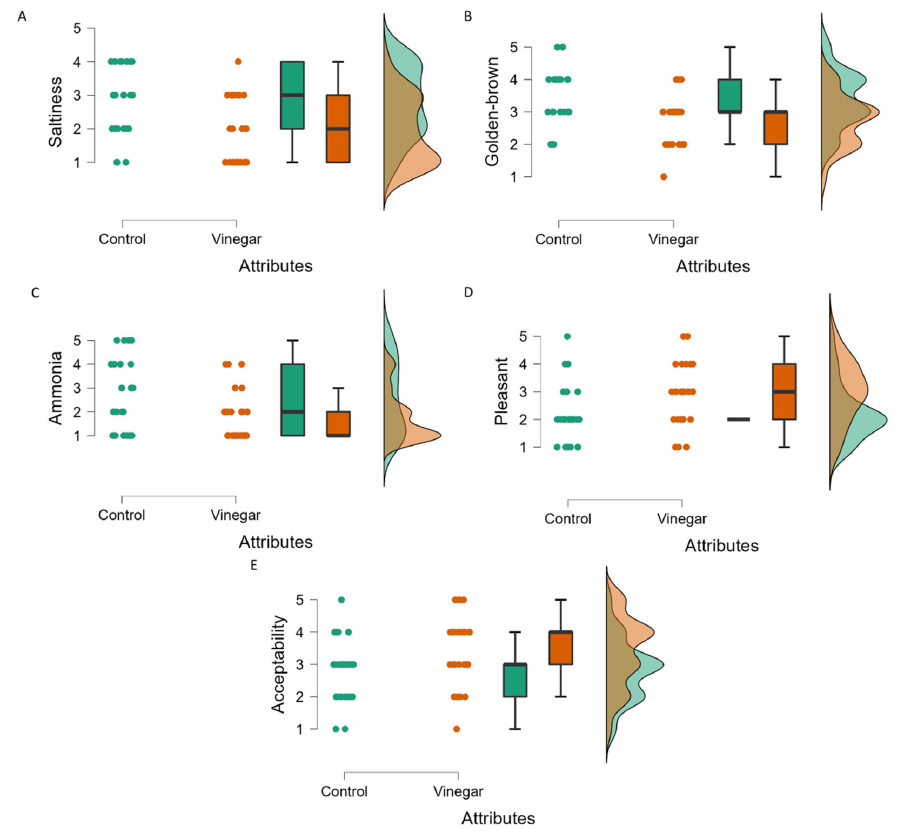
Figure 4. Raincloud plots for five significantly different sensory attributes ( p < 0.05). ( A ) Saltiness, ( B ) golden-brown color, ( C ) ammonia smell, ( D ) pleasantness and ( E ) acceptability. Raincloud plots comprise a combination of dot, box and distribution plots.